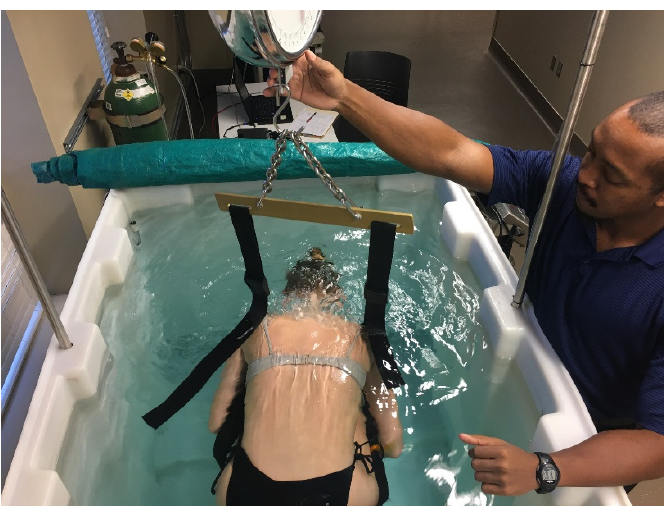
Figure 7. Hydrostatic weighing; photo courtesy of Clifton J. Holmes, PhD, in conjunction with the Exercise Physiology Laboratory in the Department of Kinesiology at the University of Alabama, Tuscaloosa.